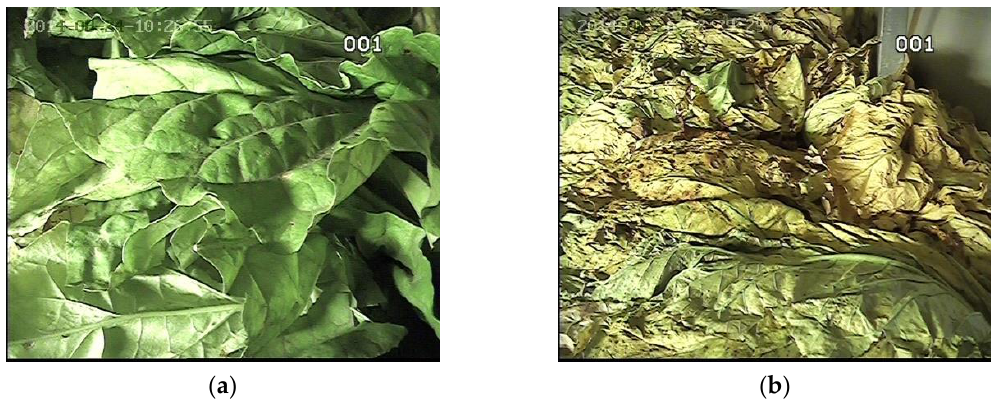
Figure 13. The raw images of tobacco leaves at the leaf-yellowing stage in the different curing phases: ( a ) early phase; ( b ) middle phase.